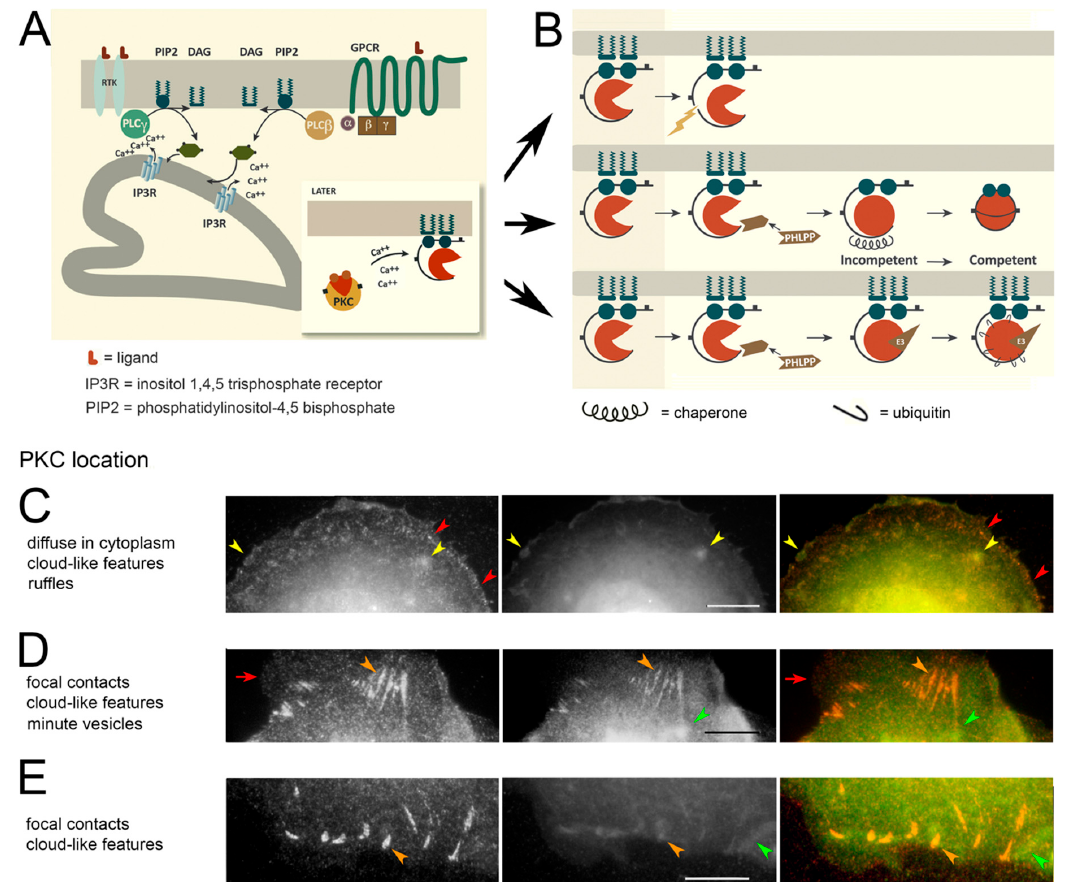
Figure 1. Protein kinase C (PKC) activation and trafficking. ( A ) PKC activation is initiated by receptor tyrosine kinases (RTKs) (left) or G protein-coupled receptors (GPCR) binding their respective ligands (L). This activates a phospholipase C (PLC β , PLC γ ) and causes the hydrolysis of L- α -phosphatidylinositol(4,5)bisphosphate (PIP2), yielding DAG along with inositol (1,4,5)trisphosphate which activates its receptor (IP3R) in the endoplasmic reticulum. IP3R allows the release of Ca ++ into the cytoplasm. Inset: The combination of DAG and Ca ++ , or just DAG for the novel isoforms, causes the protein to unfold revealing phosphatidylserine-binding sites (green circles). This allows PKC to dock on a membrane and access its substrates. ( B ) Possible fates of PKC after activation. The protein must be membrane-bound to maintain enzymatic activity. After PKC hydrolysis, the enzymatically active half becomes soluble (top panel) but has a short half-life. The hydrophobic motif (see Figure S1A,B) is dephosphorylated by Pleckstrin Homology Domain Leucine-rich repeat Protein Phosphatase (PHLPP), inactivating the enzyme. This form can be removed from the membrane by a chaperone (middle panel). PKC can be degraded in an inactive form by ubiquitination by an E3 ligase (bottom panel). ( C – E ) Vinculin (left panel, red) colocalized with PKC (middle panel, green), in untreated cells (see Section 2.3. Localization by Indirect Immunofluorescence ). ( C ) PKC is on actin-rich ruffles and cloud-like features (yellow arrowheads) but absent from some focal contacts (red arrowheads). ( D ) PKC binds to some cloud-like features without vinculin (green arrowheads). It is colocalized with vinculin in most focal adhesions (orange arrowheads) but is absent occasionally (red arrowheads). ( E ) PKC binds to focal contacts (orange arrowheads) but is also found between these structures in a form that is free of vinculin (green arrowheads). ( C – E ) Bars = 10 µm.